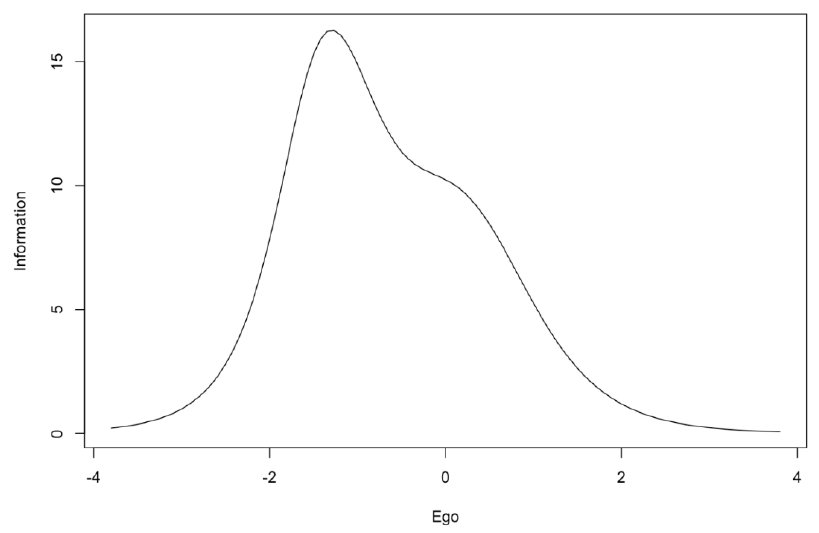
Figure 2. Information curve for the ego subscale.